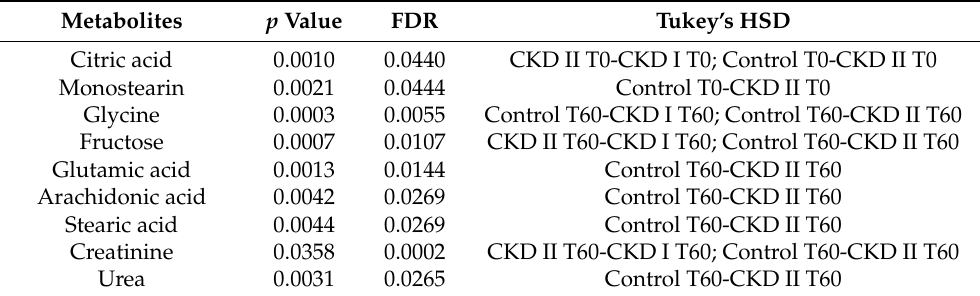
Table 5. Results obtained by univariate analysis of serum metabolites at T0 and T60. Table 4. Results obtained by univariate analysis of serum metabolites at T0 and